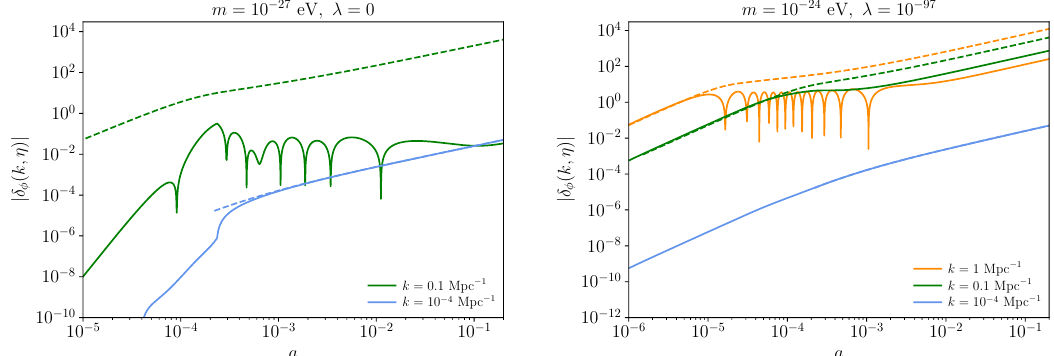
Figure 4 . Evolution in time of the dark matter transfer functions compared to the standard (cid:3)CDM evolution, represented by dotted lines, with Jeans scale at equality k J ( z eq ) = 0 : 03 Mpc (cid:0) 1 and k J ( z eq ) = 0 : 11 Mpc (cid:0) 1